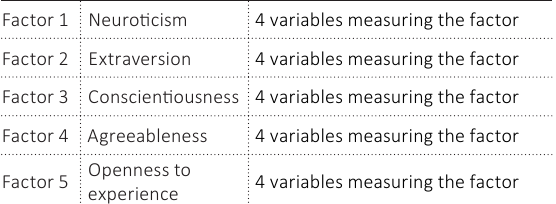
Table 2. Big Five Personality Traits